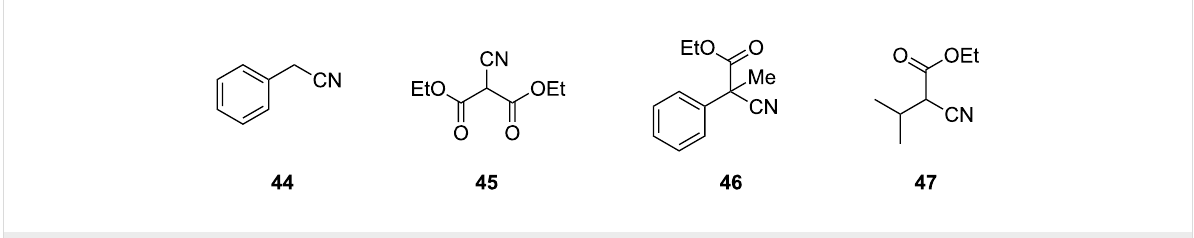
Figure 2: Substrates which did not react under the optimised conditions.